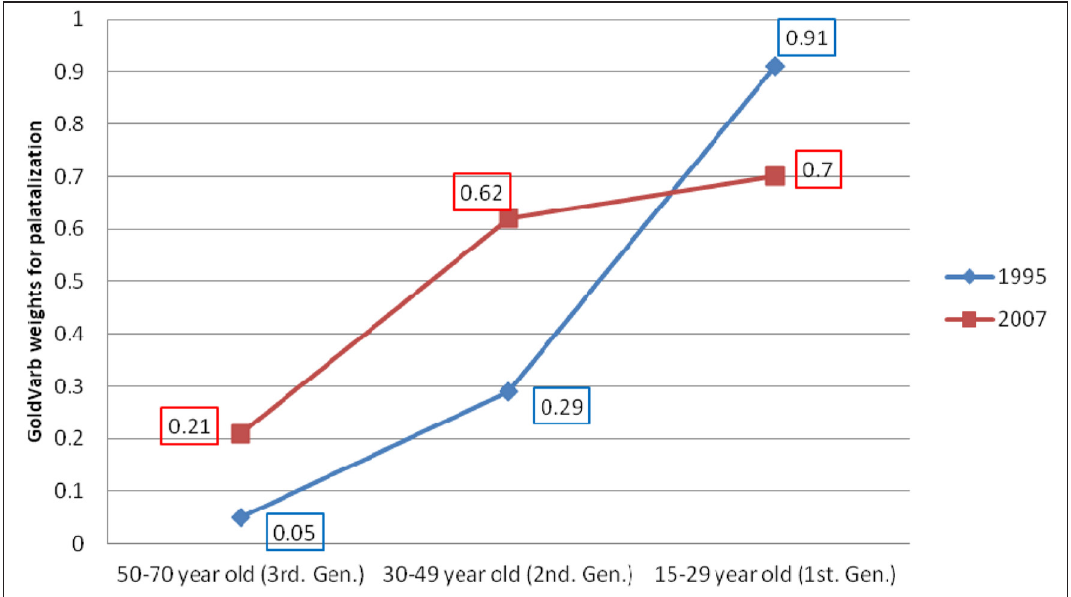
Figure 4: Comparison of rates of palatalization of dental stops followed by /i/ according to age in